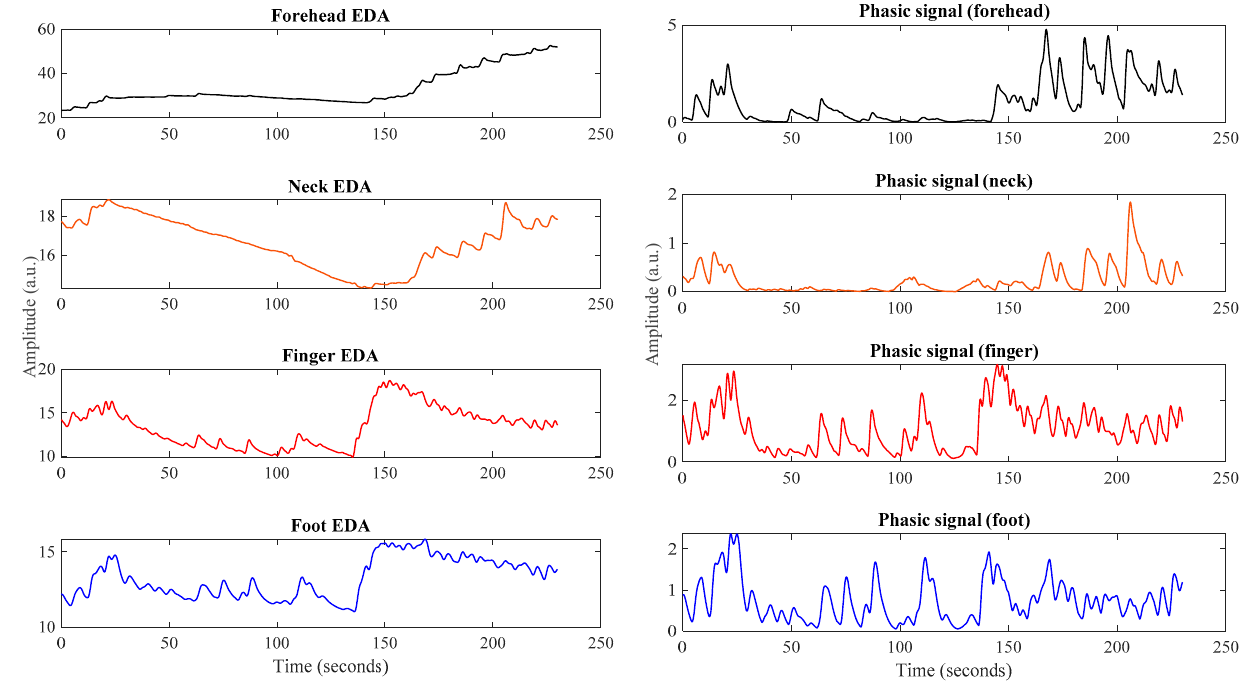
Figure 2. EDA signals collected from different body sites ( left side), Corresponding phasic signals ( right side).